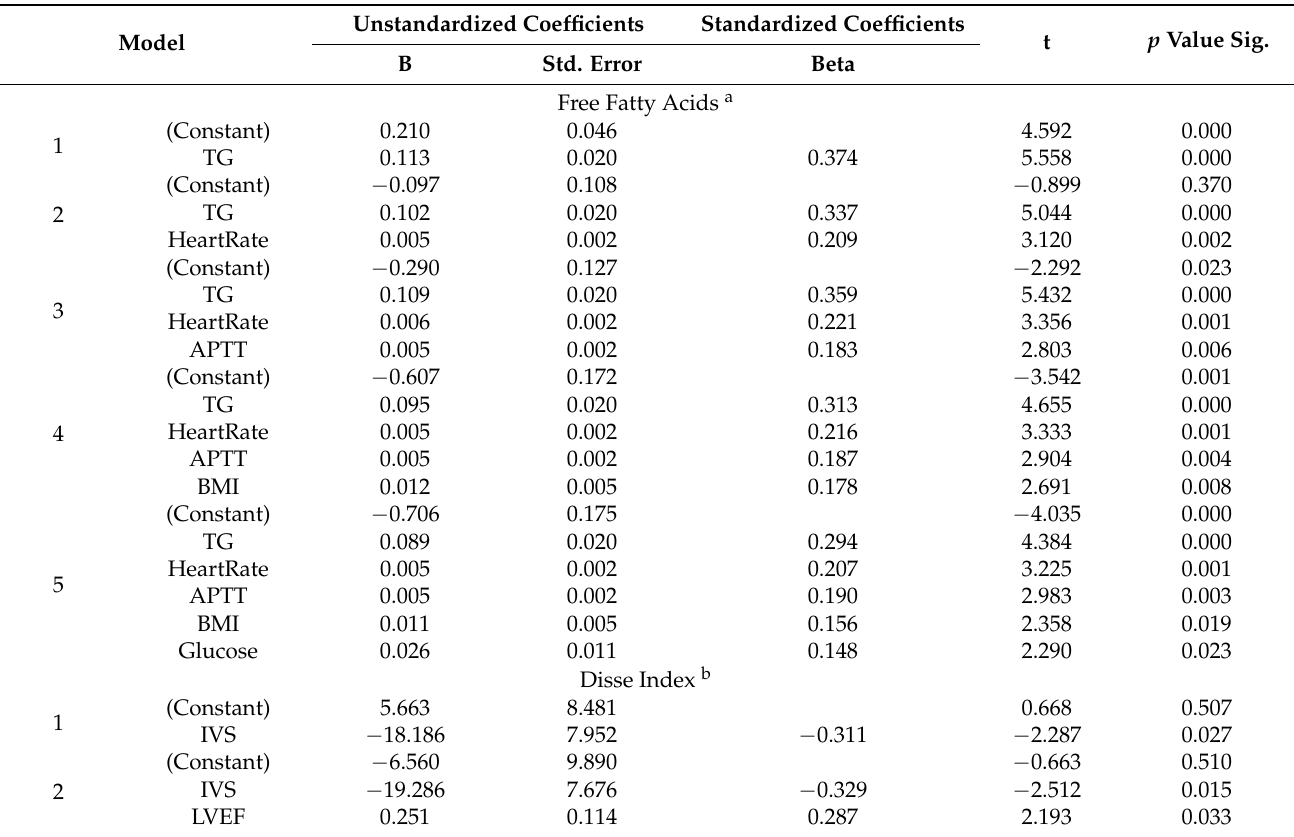
Table 3. Multiple linear regression to assess the relationship between FFA and Disse index with patients’ perioperative char-